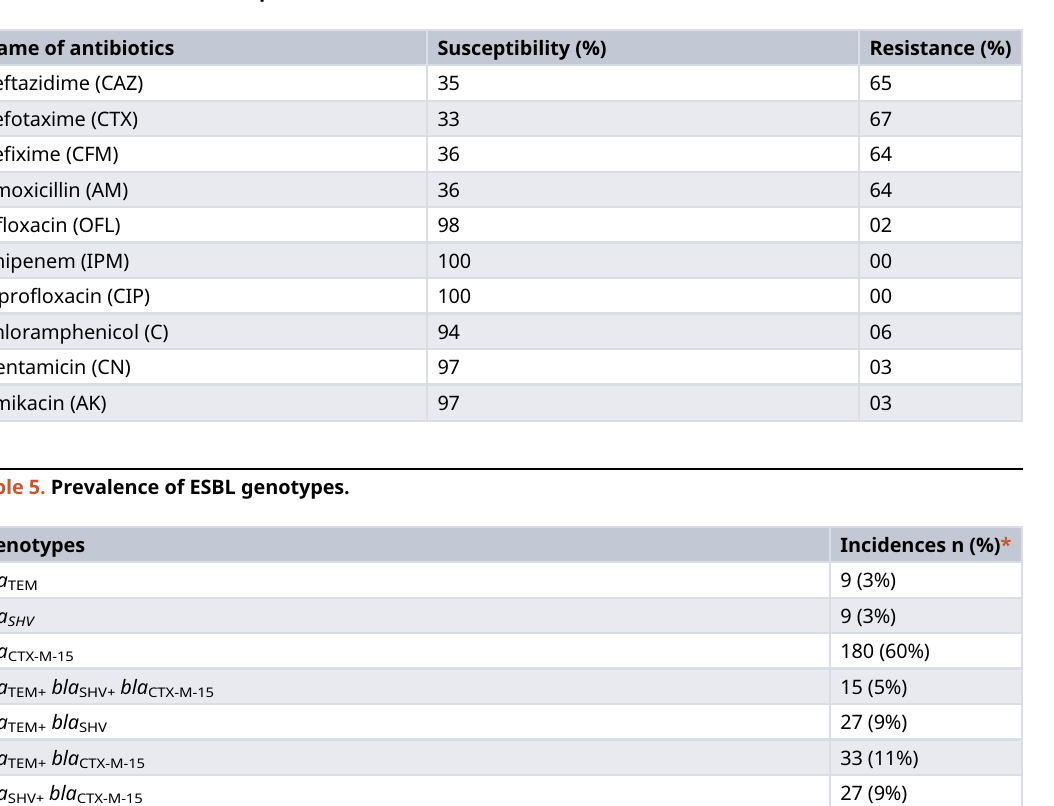
Table 4. Antibiotic resistance